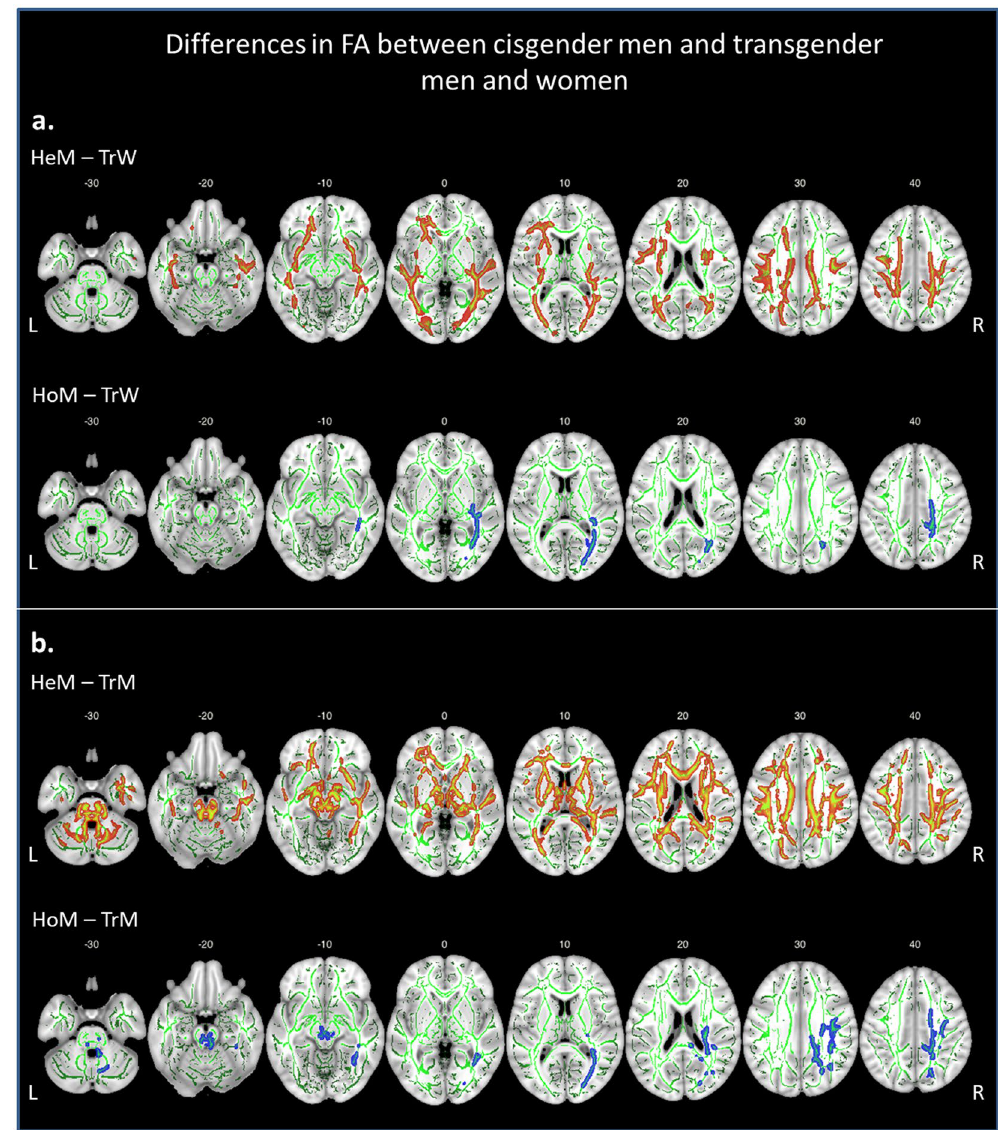
Figure 2. Whole brain voxel-wise group differences in FA ( p < 0.05, FWE -corrected) between homo- and heterosexual cisgender men (HoM/HeM) and transgender women (TrW, part a), and transgender men (TrM, part b). The lower panel of part b. HoM – TrM, is displayed at a slightly more lenient threshold of p < 0.06, FWE -corrected. Significant clusters are projected on the mean FA skeleton (green) using the “tbss fill” procedure in FSL; Slice labels indicate MNI z-coordinates; L = left, R =